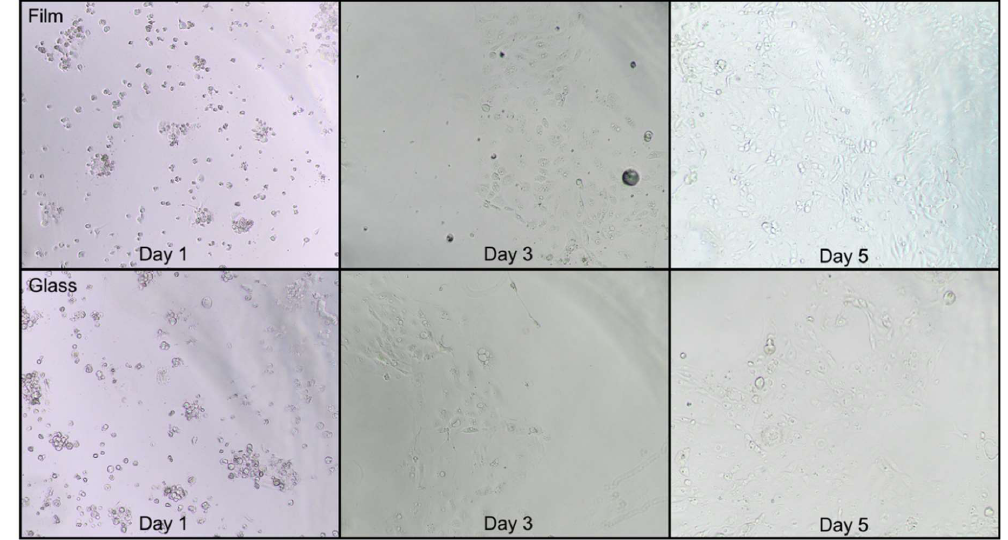
Figure 3. Cell growth in film and glass-bottom plates in days 1, 3 and 5 after seeding. Cell growth was better and convergence was attained in film- but not in glass-bottom plates at day 5 (10 ×